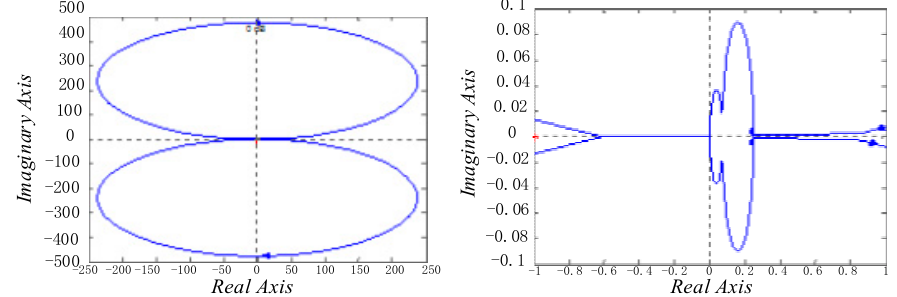
Figure 18. Impedance ratio Nyquist curve of cascade system.